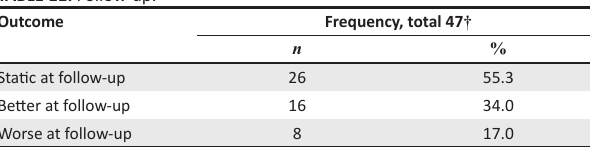
TABLE 11: Follow-up. Outcome